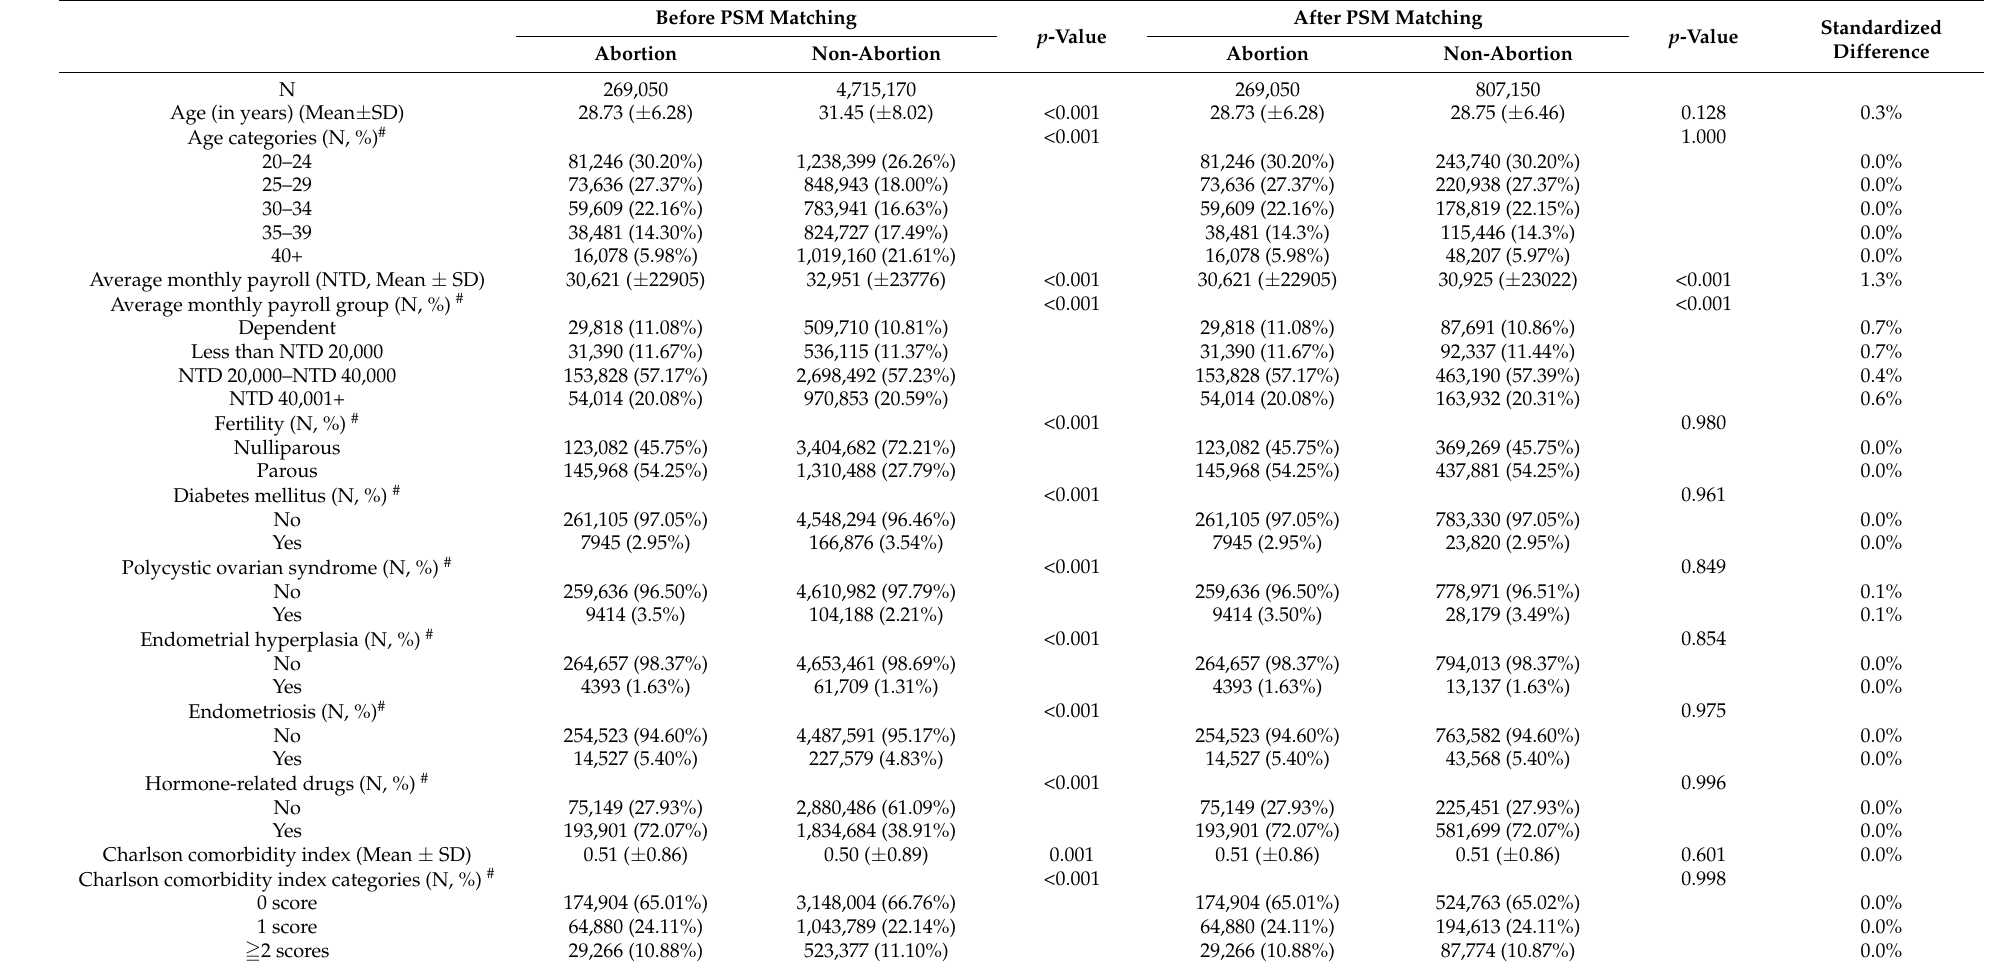
Table 1. Demographic characteristics among abortion and non-abortion cohorts before and after propensity score